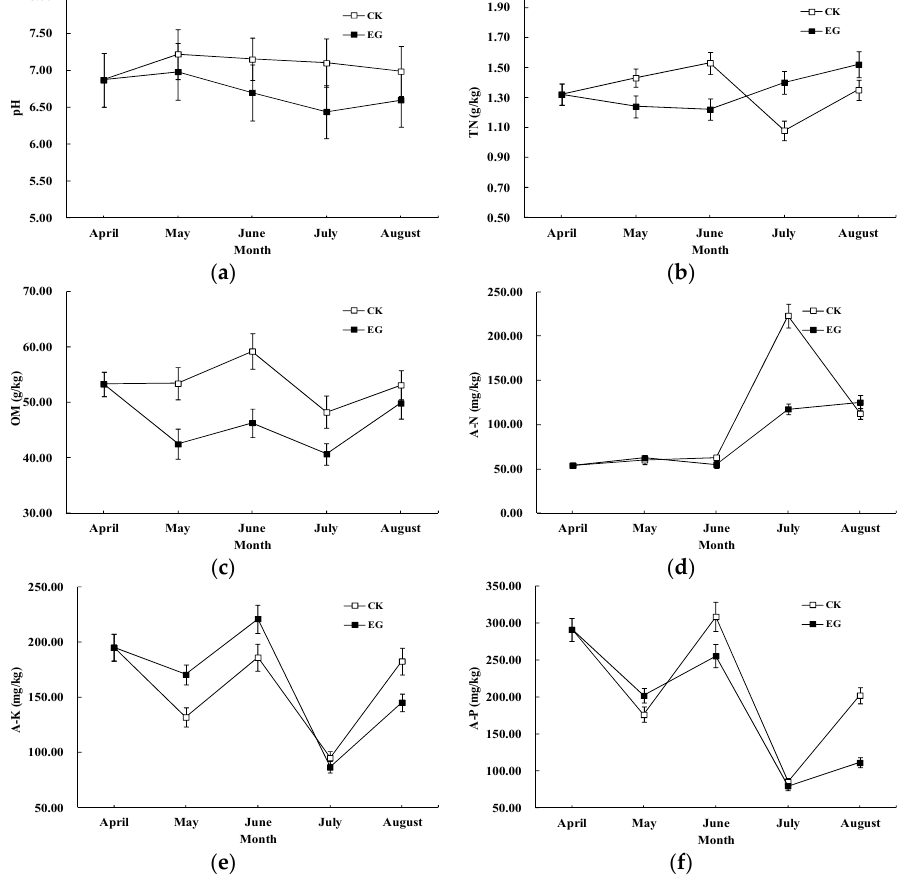
Figure 2. Changes of pH and major nutrients in kiwifruit planting soil: ( a ) pH; ( b ) TN; ( c ) OM; ( d ) A-N; ( e ) A-K; ( f )